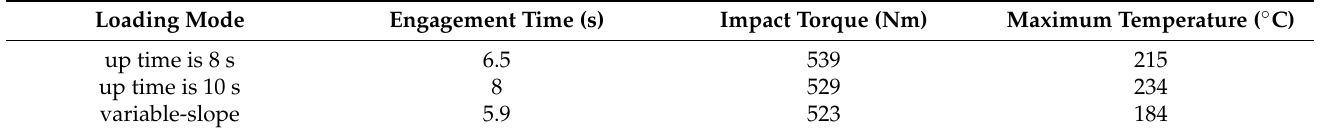
Figure 23. Results of variable slope pressure loading. ( a ) Main/driven disk speed curve ( b ) Torque curve ( c ) Temperature curve.